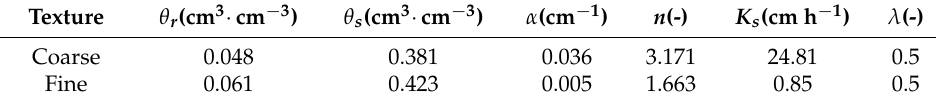
Table 1. Mualem-van Genuchten hydraulic parameters for the coarse and fine texture sediments.